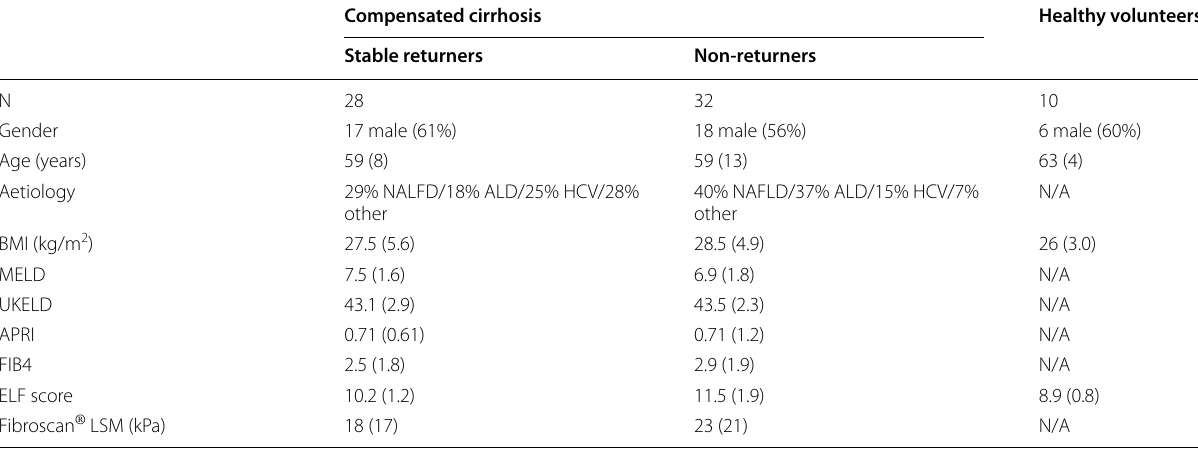
Table 2 Characteristics of the 60 compensated cirrhosis cohort divided into 28 stable control patients followed longitudinally in this paper, and those non-returner patients excluded as they either failed to return for repeat assessments or developed a clinical outcome. Also shown is the 10 healthy volunteer group followed